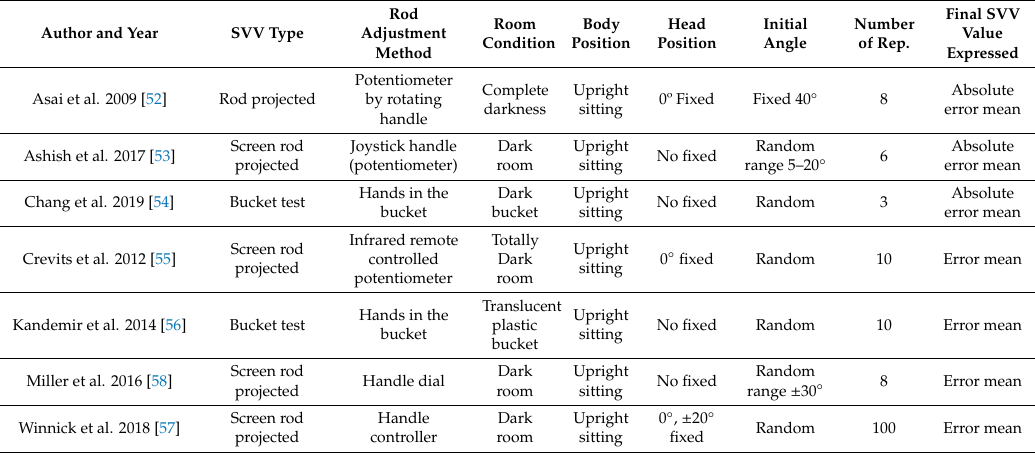
Table 3. Characteristics of the SVV measure in studies included in the review.